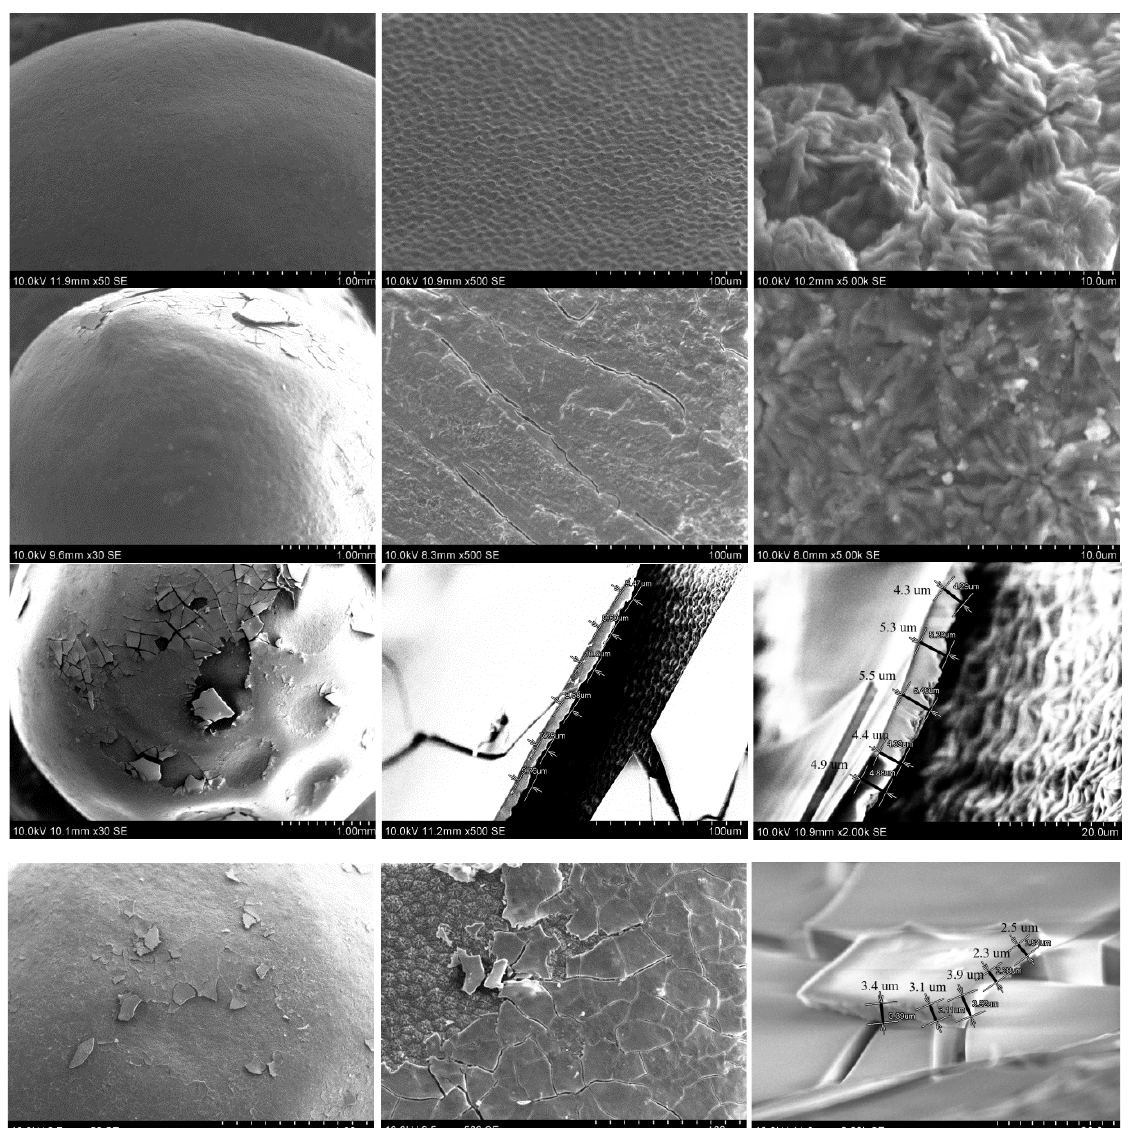
Figure 3. SEM micrographs of the pea seeds after diluted SiO 2 sol deposition: 025EtOH (first raw), 025H 2 O (second raw), 05EtOH (third raw), and 05H 2 O (fourth raw).